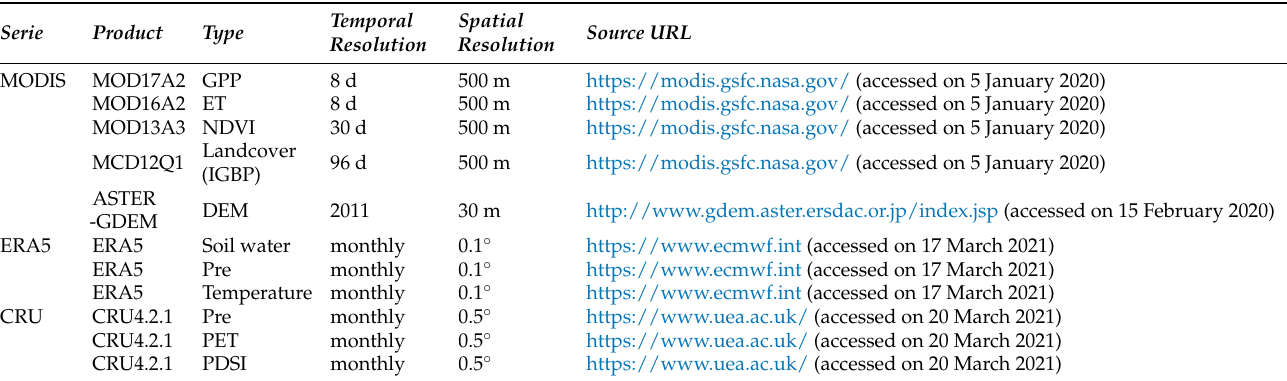
Table 1. Data Product Type and